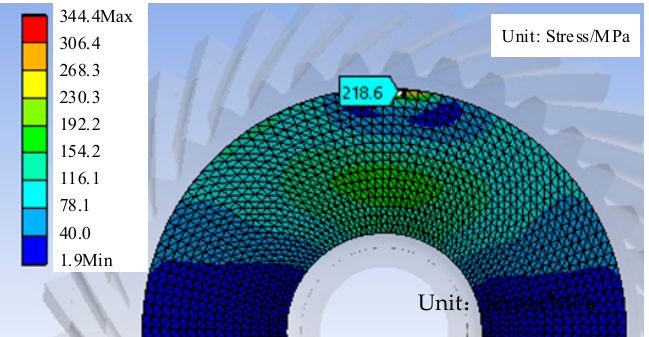
Figure 17. Equivalent stress at the position monitored in the test at 4th ND rotational speed.